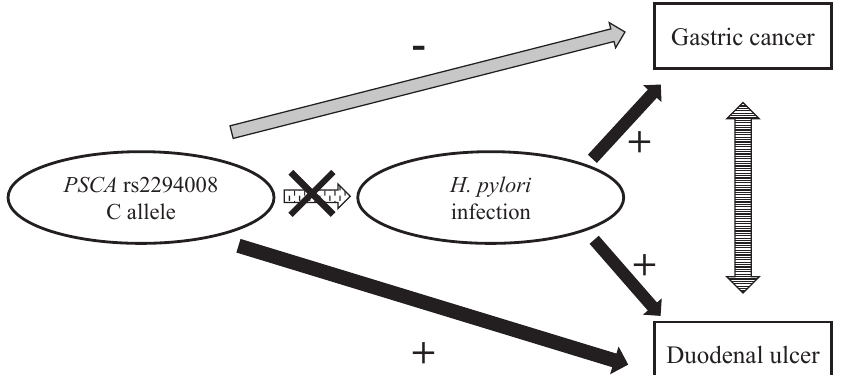
Figure 1. Association between duodenal ulcer / gastric cancer and host factors ( PSCA rs2294008). H. pylori infection increased the risk of both gastric cancer and duodenal ulcer. On the other hand, PSCA rs2294008 C-allele decreased the risk of gastric cancer and increased that of duodenal